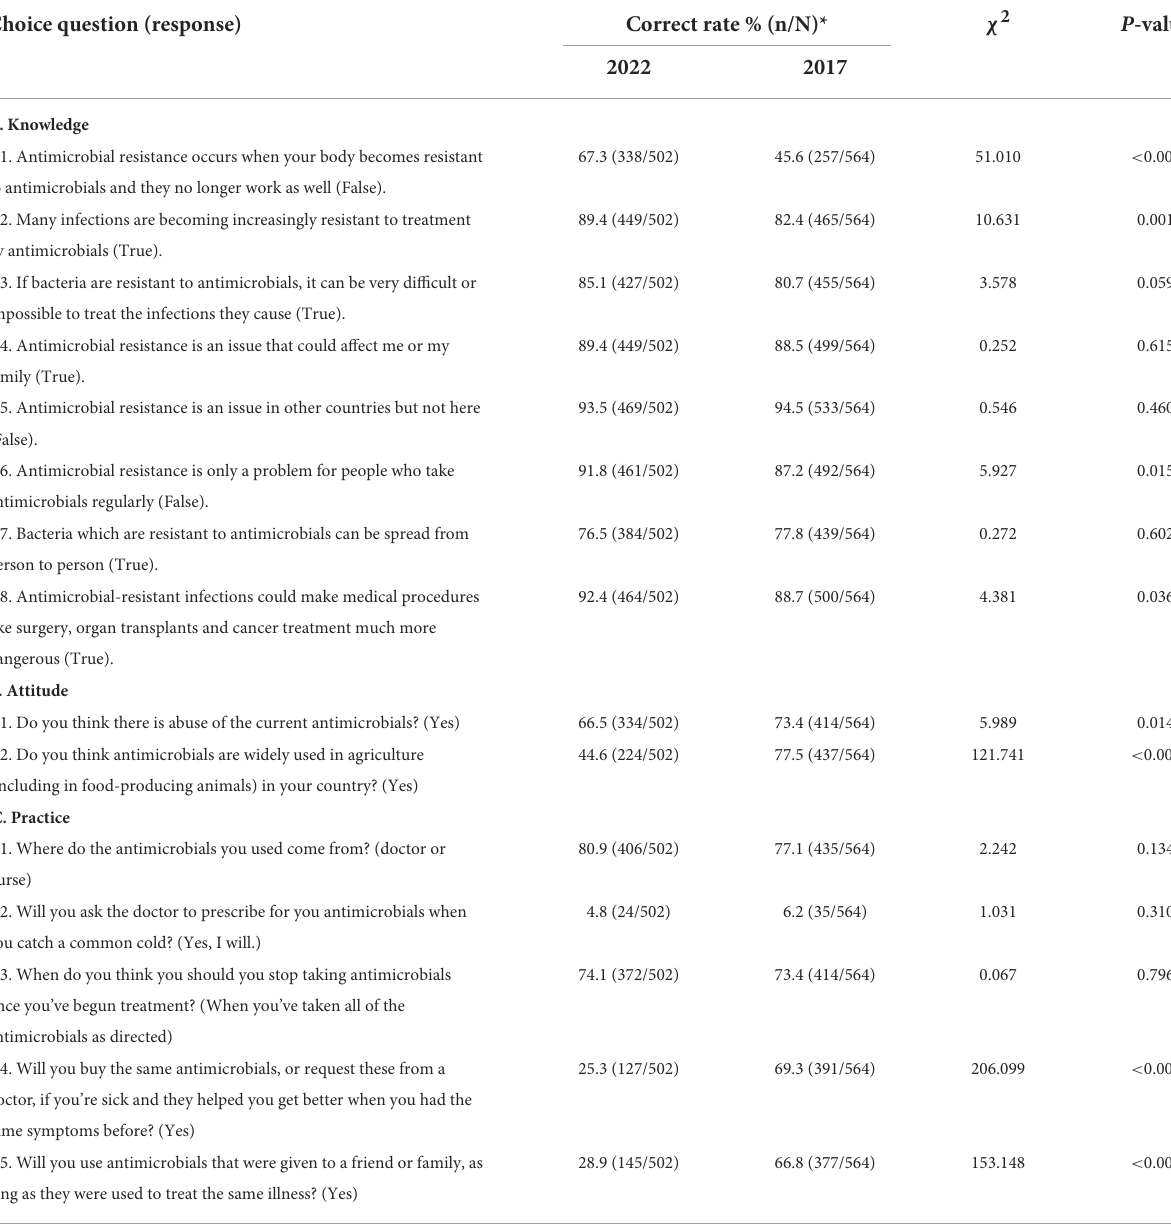
TABLE 2 The knowledge, attitude and practice of respondents regarding antimicrobials. Choice question